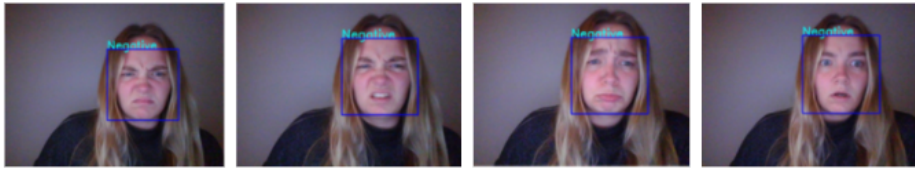
Figure 27. Correctly Classified Real-Time 4 × Negative.